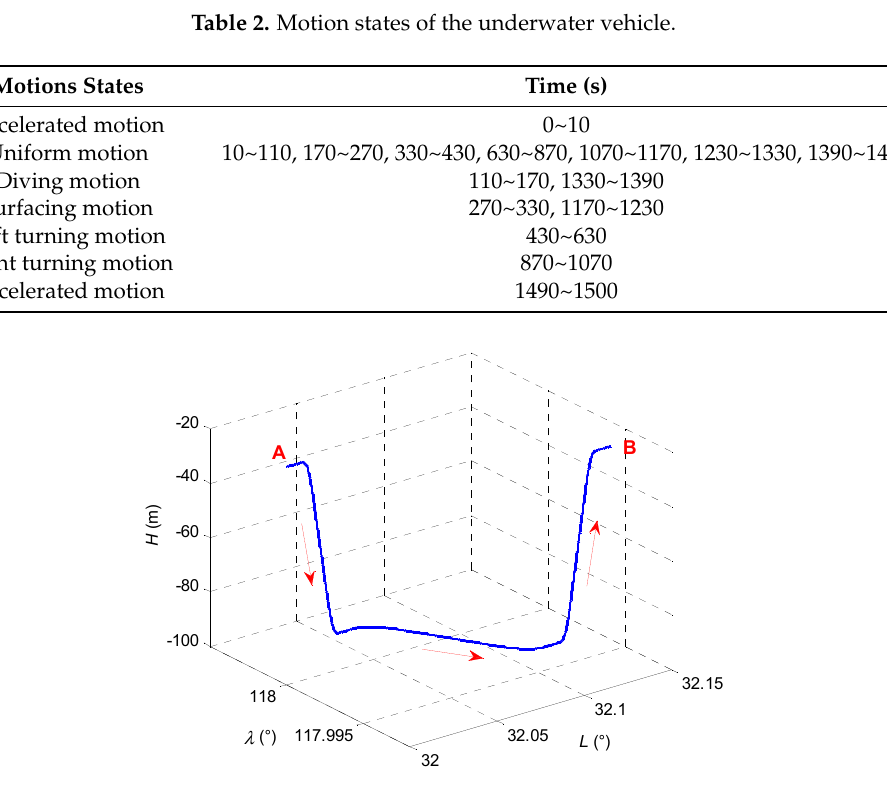
( b ) Figure 7. Velocity errors: ( a ) East velocity error; ( b ) North velocity error.